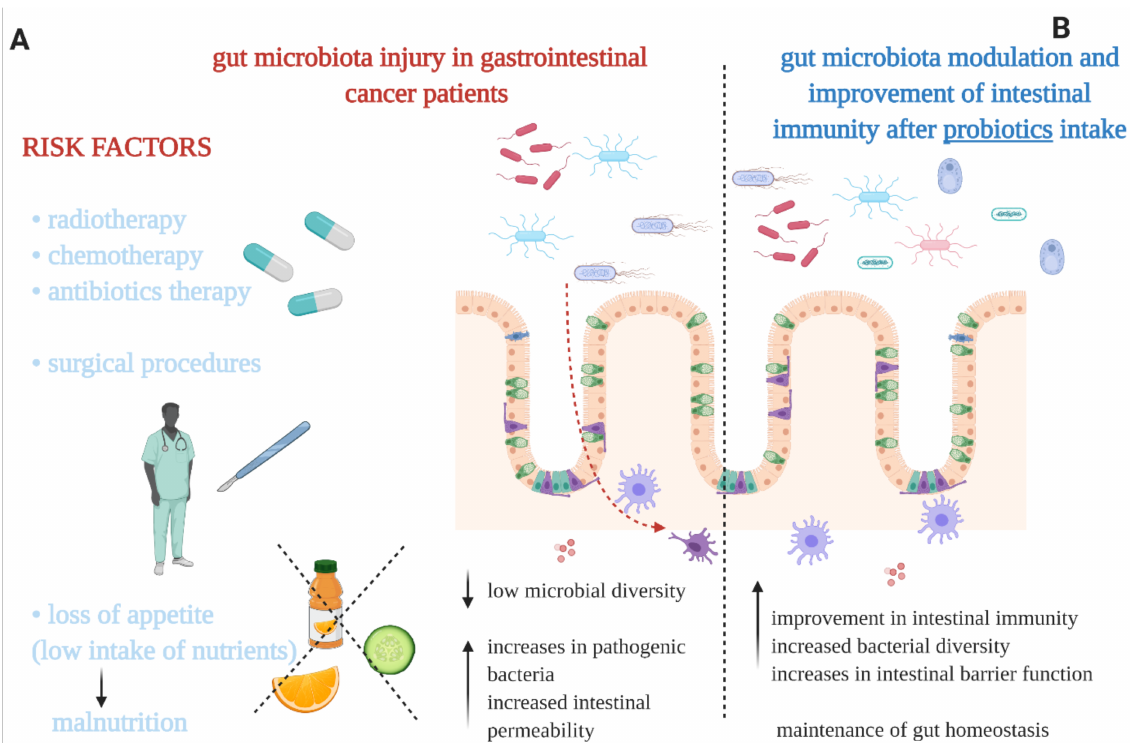
Figure 1. ( A ) The main factors causing a gut microbiota imbalance in gastrointestinal cancer patients. ( B ) Some of the potential effects on gut microbiota and intestinal immunity evident after administration of probiotics. Our proposals based on the literature [1,14,15,23]. Table 1. Bacterial gut microbiota imbalance in selected gastrointestinal